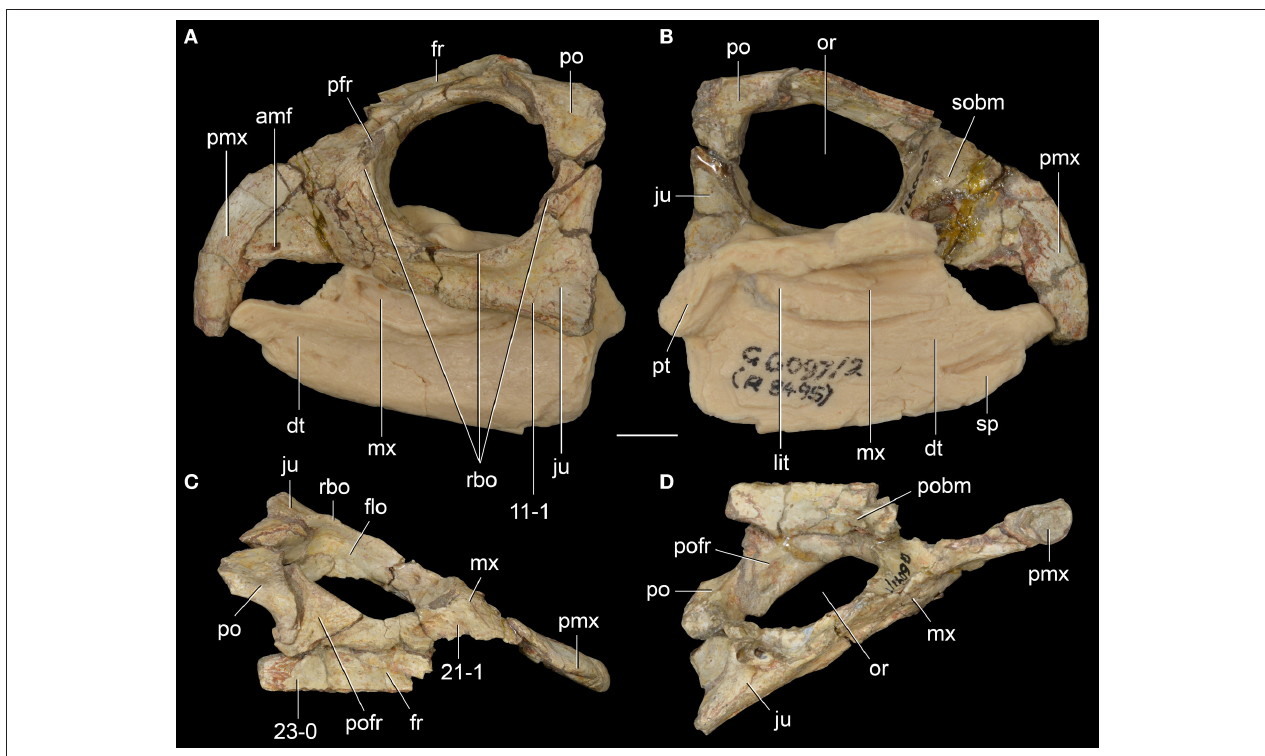
FIGURE 7 | Langeronyx brodiei nov. gen. et nov. comb. from the Anisian of England. WARMS G6097/1, G6097/2 (part of the holotype) in left lateral (A) , left medial (B) , dorsal (C) , and ventral (D) views. Numbers indicate character-states synapomorphic of Langeronyx and rhynchosaurids to the exclusion of stenaulorhynchines and Rhynchosaurus articeps . Abbreviations: amf, anterior maxillary foramen; dt, dentary; flo, floor of the orbit; fr, frontal; ju, jugal; lit, lingual teeth; mx, maxilla; or, orbit; po, postorbital; pofr, postfrontal; prf, prefrontal; pmx, premaxilla; pobm, primary olfactory bulb mold; pt, pterygoid; rbo, raised border of the orbit; sobm, secondary olfactory bulb mold. Scale bar equals